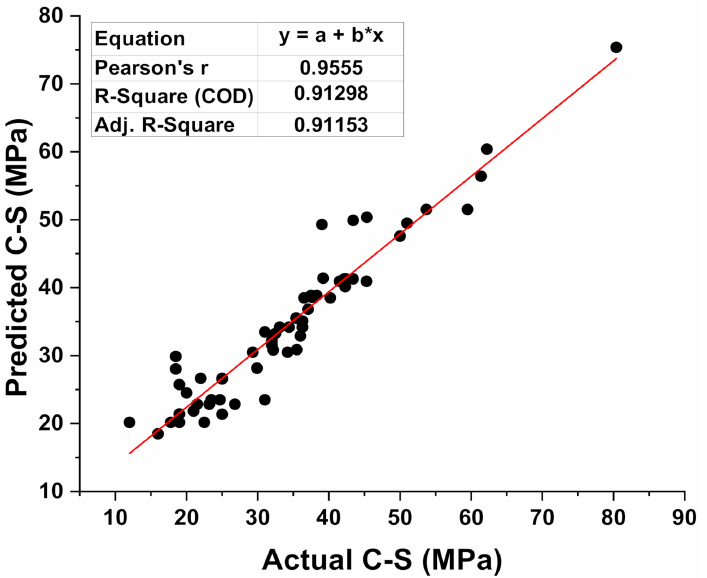
Figure 5. Correspondence among the experimental and predicted results of SVM